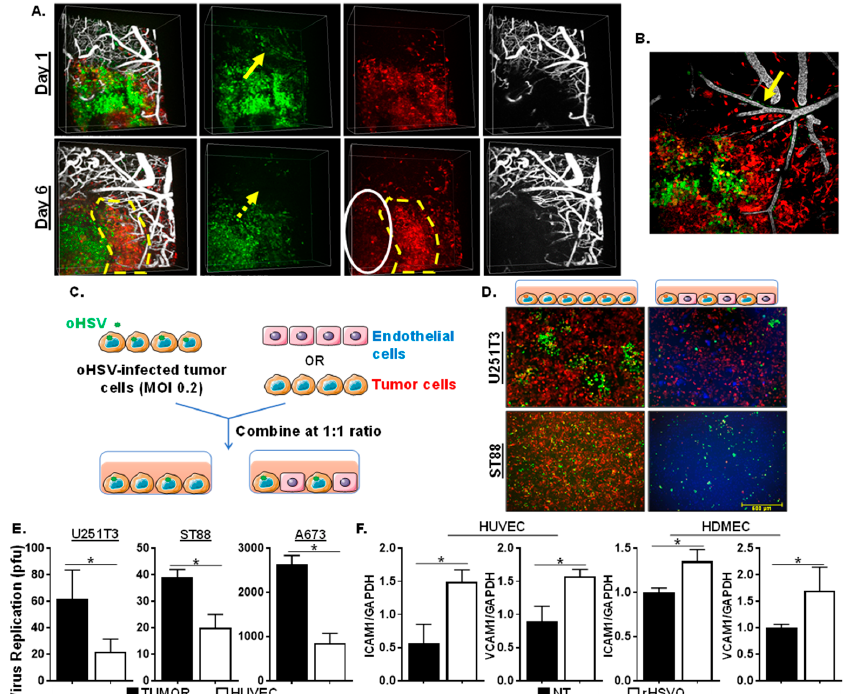
Figure 1. Endothelial cells reduce oncolytic herpes simplex virus-1 (oHSV) replication. ( A ) Intravital imaging revealed oHSV infection of tumor cells away from and close to vessels (yellow arrow) one day post-infection. On day 6 post viral infection, GFP signal in cells lining the vasculature had disappeared (yellow dot arrow) but, tumors not adjacent to vasculature (white oval) had sutained GFP-positive virus presence and reduced RFP-positive tumor cells over time. ( B ) Maximum Intensity Projection of inset shown in panel ( A ). Yellow arrow indicated oHSV-infected cells along perfused blood vessels. Green: oncolytic HSV-1 (GFP), Red: GBM12-RFP, White: Alexa Fluor 647-conjugated BSA. ( C ) Schematic diagram of experimental design for co-culture assay with tumor and endothelial cells. Sarcoma cells that stably express mCherry were infected with oHSV (rHSVQ: GFP) for an hour before being overlaid on either endothelial cells, which were stained with Cell Tracker Blue or mCherry expressing sarcoma cells at a 1:1 ratio. ( D ) Images were taken 24 h after infection to compare GFP expression in sarcoma cocultured with endothelial or sarcoma cells. ( E ) Viral titers were measured by standard plaque forming unit assay 24 h post-infection. ( F ) Human umbilical vein endothelial cells (HUVEC) and human dermal microvascular endothelial cells (HDMEC) were plated and treated with rHSVQ (MOI = 0.2) on 12-well plates. Quantitative real-time PCR (Q-PCR) analysis was done to examine for changes in gene expression of ICAM1 and VCAM1 between rHSVQ and Rapid Antiangiogenesis Mediated By Oncolytic Virus (RAMBO) infected endothelial cells 24 h post-infection. NT = No Treatment, * p <